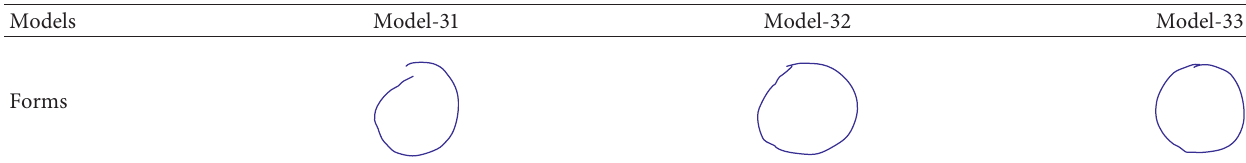
Table 8: Examples of “circle” written by writer-3.